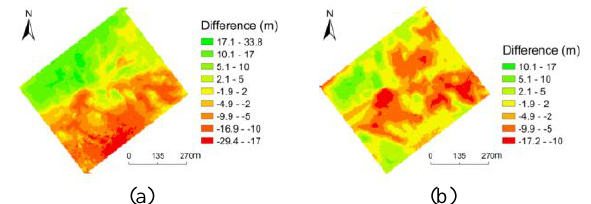
Figure 6. Comparison between Contour-DEM and UAV-DEMs, georeferenced by (a) POS and by (b) GCPs In addition, Fig. 7. show the frequency histogram of difference values between Contour-DEM and UAV-DEMs, georeferenced by fight control data and ground control points, respectively.